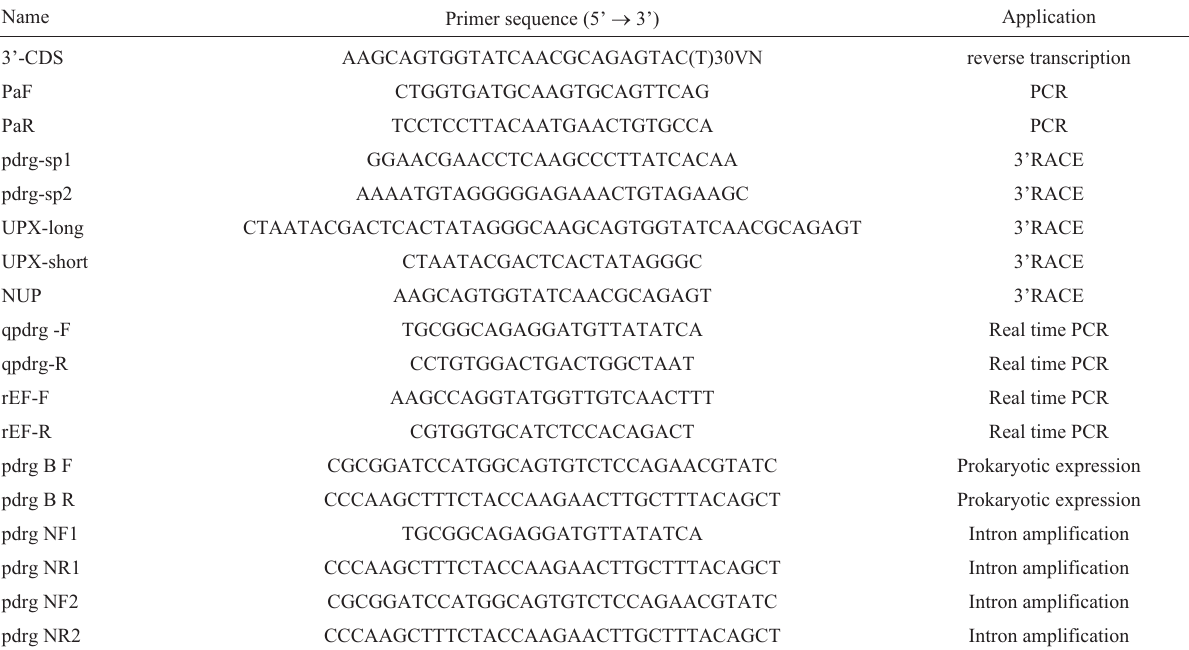
Table 1 - Primers used for gene cloning and expression